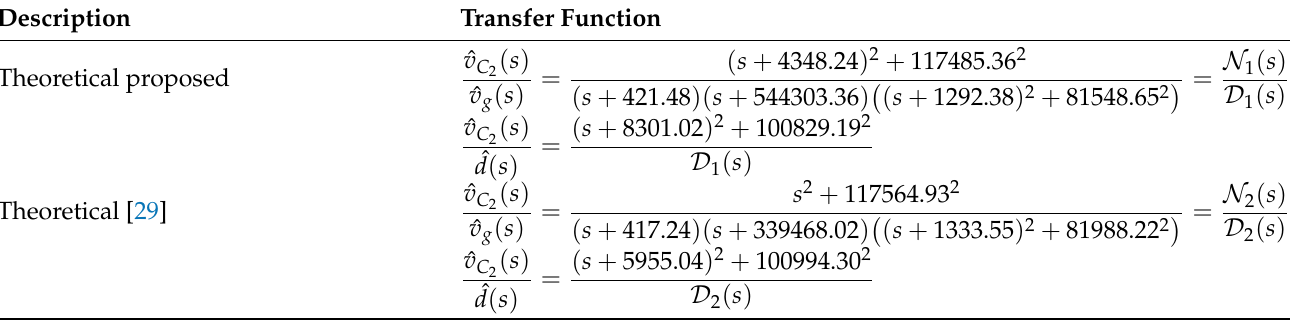
Table 10. Theoretical transfer functions of the Zeta converter presented in